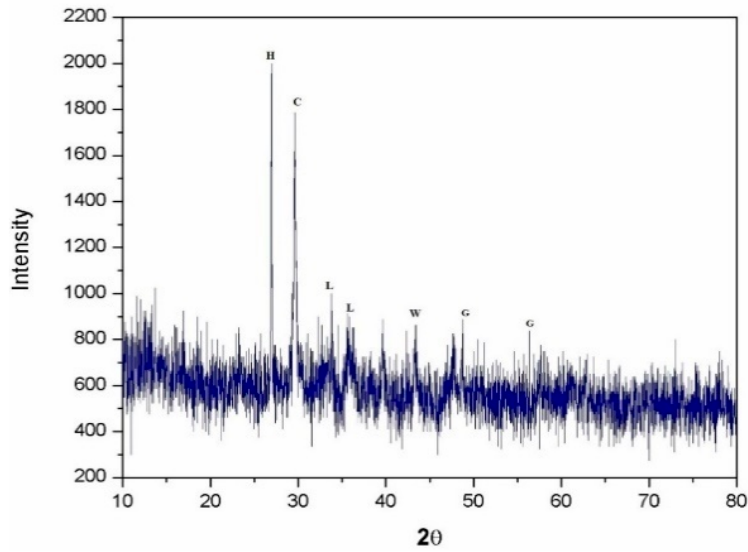
Figure 12. X-ray diffraction analysis of EOF steel slag.